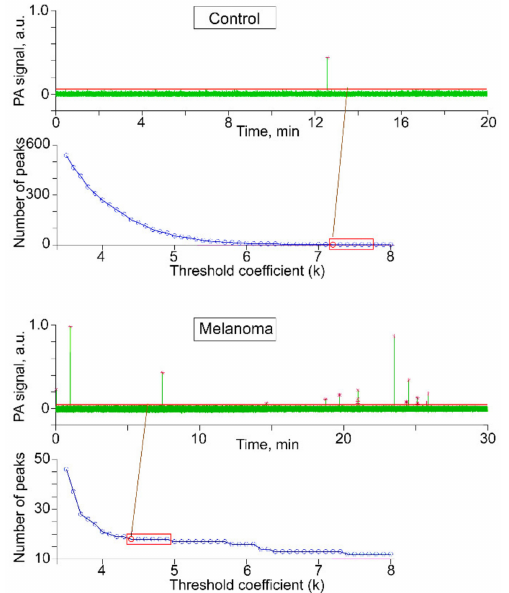
Figure 9. Peak detection threshold